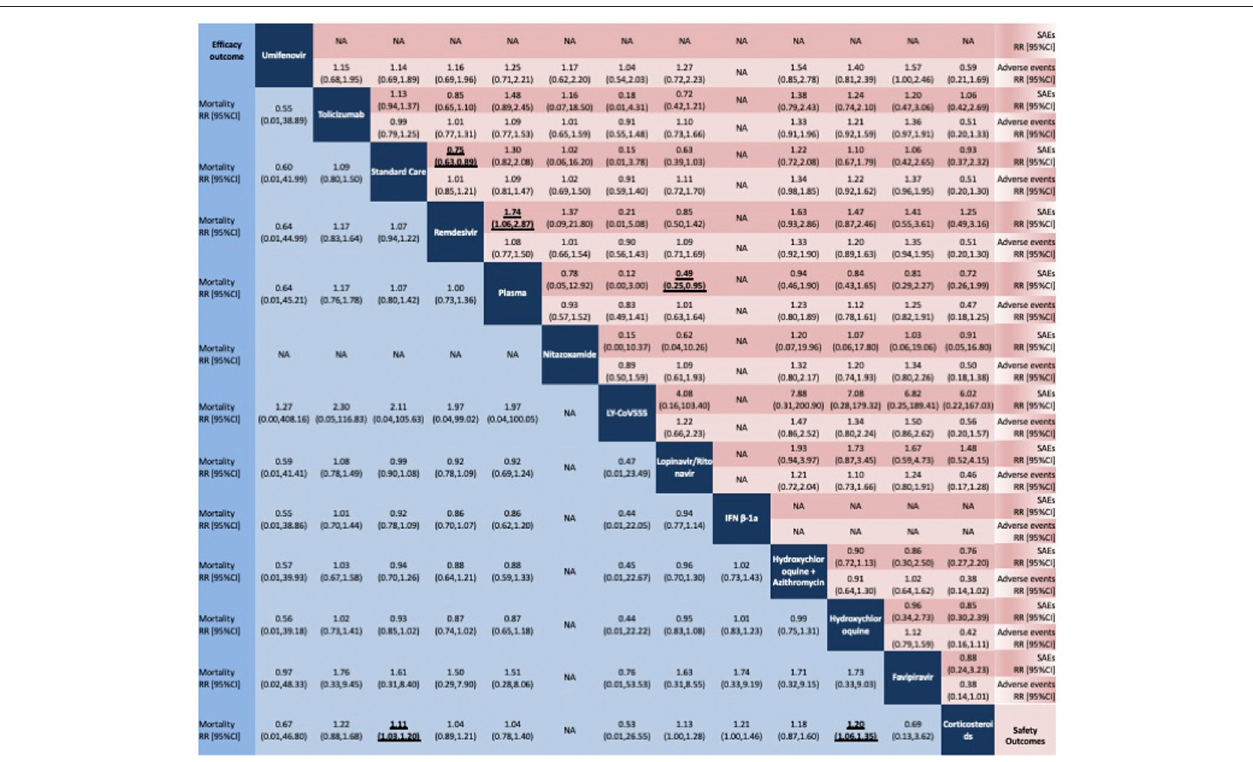
FIGURE3| Network meta-analysis ofall-cause mortality(blue), adverse events(lightred) seriousadverseevents(red). Pharmacological treatments arereported in alphabetical order. Comparisons should be read from left to right. All-cause mortality and safety estimates are located at the intersection between the column-de fi ning and the row-de fi ning treatment. For all-cause mortality, RRs above 1favor the column-de fi ning treatment. For safety, RRs above 1 favor the row-de fi ning treatment. We incorporated the GRADE judgments in the fi gure. Estimates in gray have a very low or low certainty of evidence.